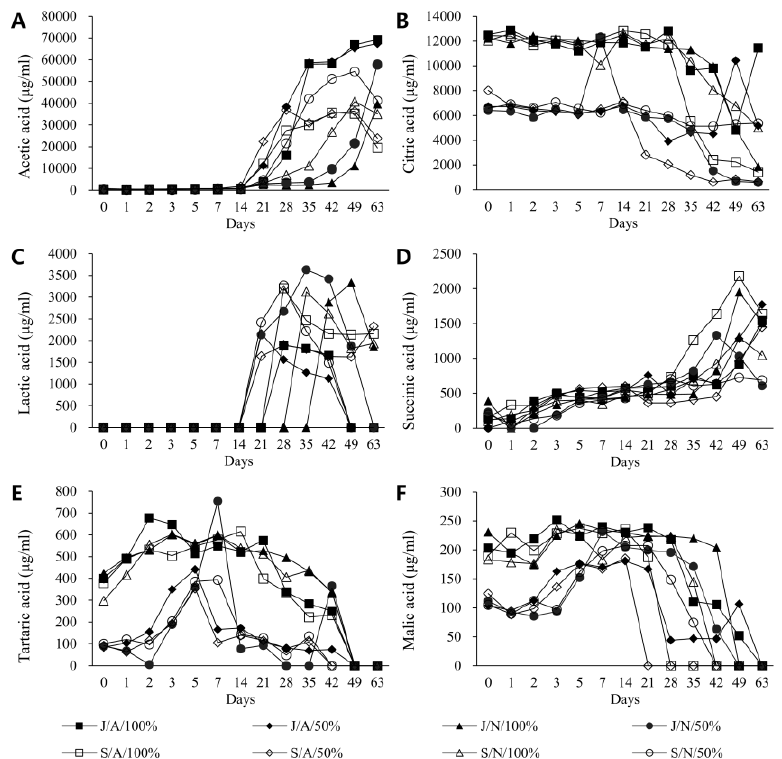
Figure 2. Quantitative changes of major organic acids by fermentation conditions and duration. Concentrations of ( A ) acetic acid, ( B ) citric acid, ( C ) lactic acid, ( D ) succinic acid, ( E ) tartaric acid, and ( F ) malic acid in vinegar samples over the entire period of fermentation were measured. Vinegar was fermented in Gochang jars (J) or stainless steel (S) containers. They were fermented under conditions of adjusted temperature/oxygen (A) or were fermented outdoors in a natural state (N). Two types, 100% and 50%, were used for fermentation according to concentrations of bokbunja raw materials. Among major organic acids, lactic acid had the third highest concentration in